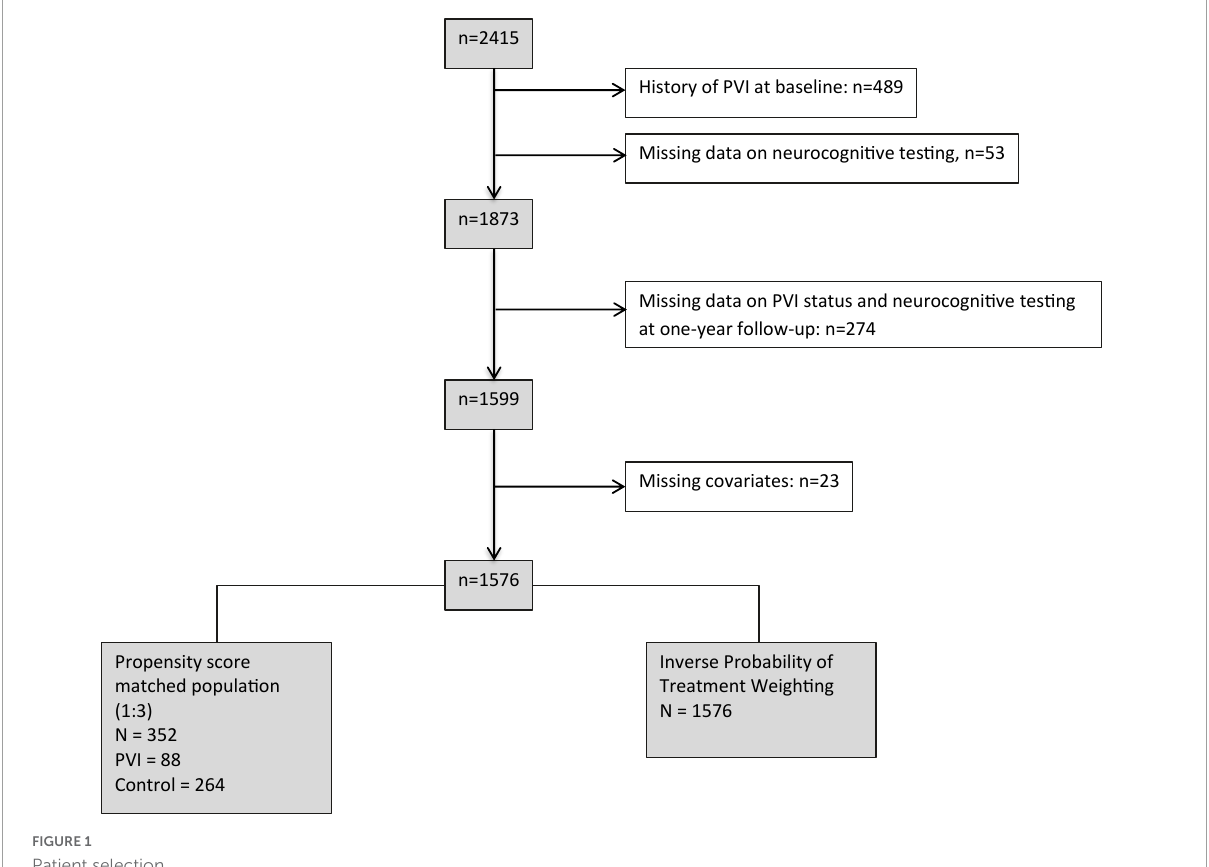
FIGURE1 Patient